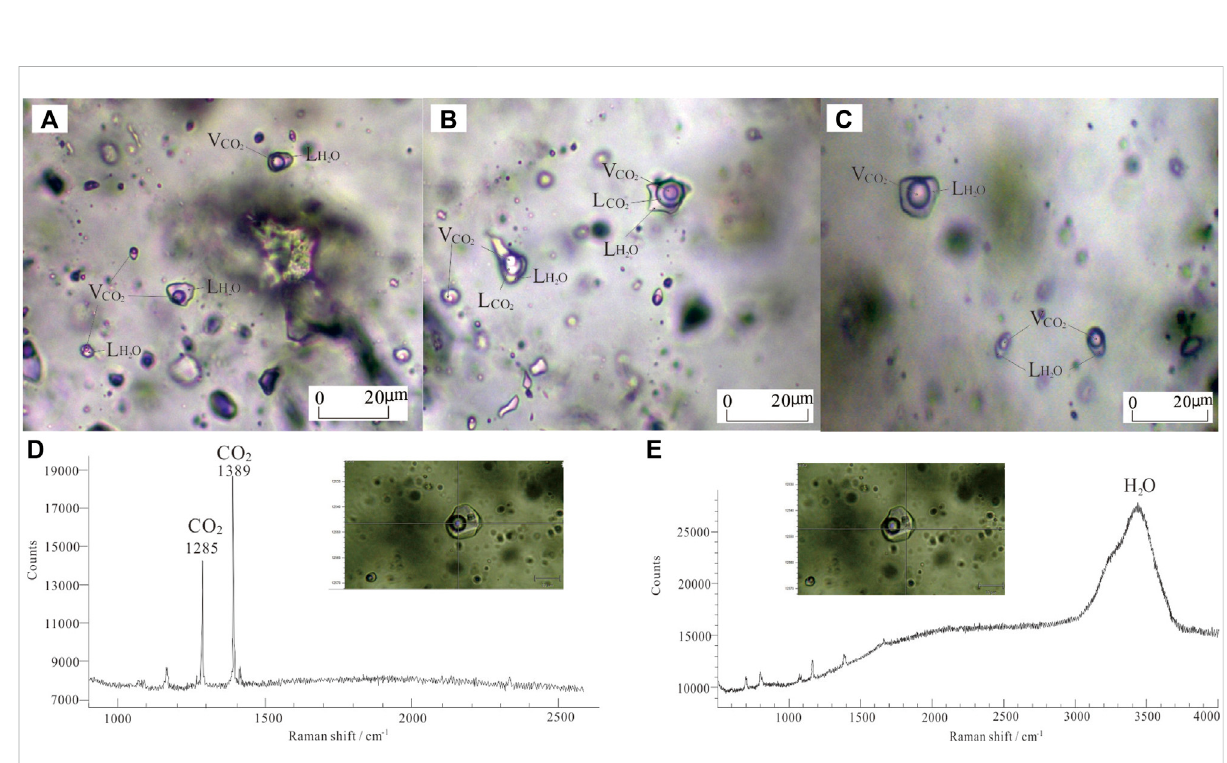
FIGURE 6 Photomicrographs (A – C) and laser Raman (D,E) spectrogram of fl uid inclusions in the Houge ’ zhuang gold